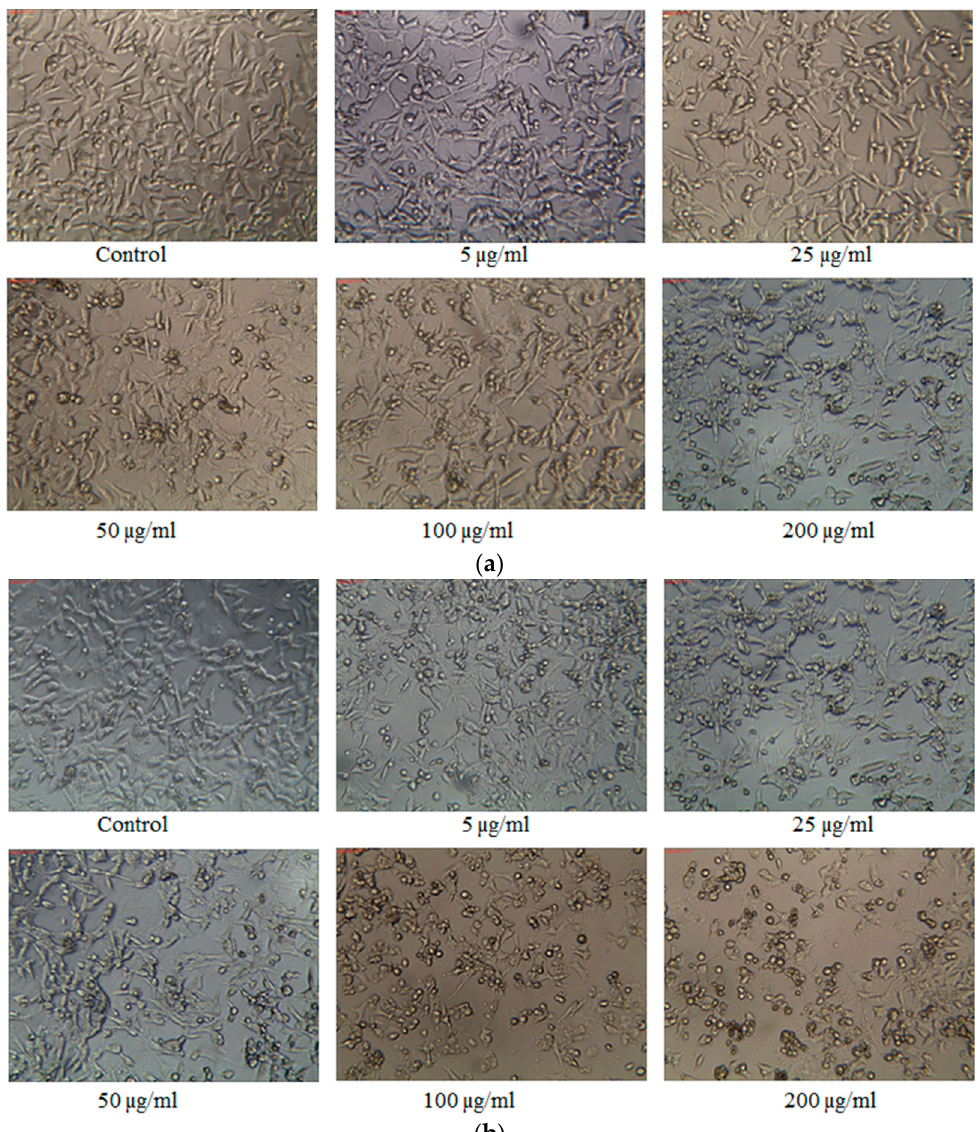
Figure 6. Morphology of HCT-116 colorectal cancer cells treated with different concentrations of pomegranate peel ethanol extracts obtained by UAE at 50 W after 48 h ( a ) and 72 h ( b ) of treatment.